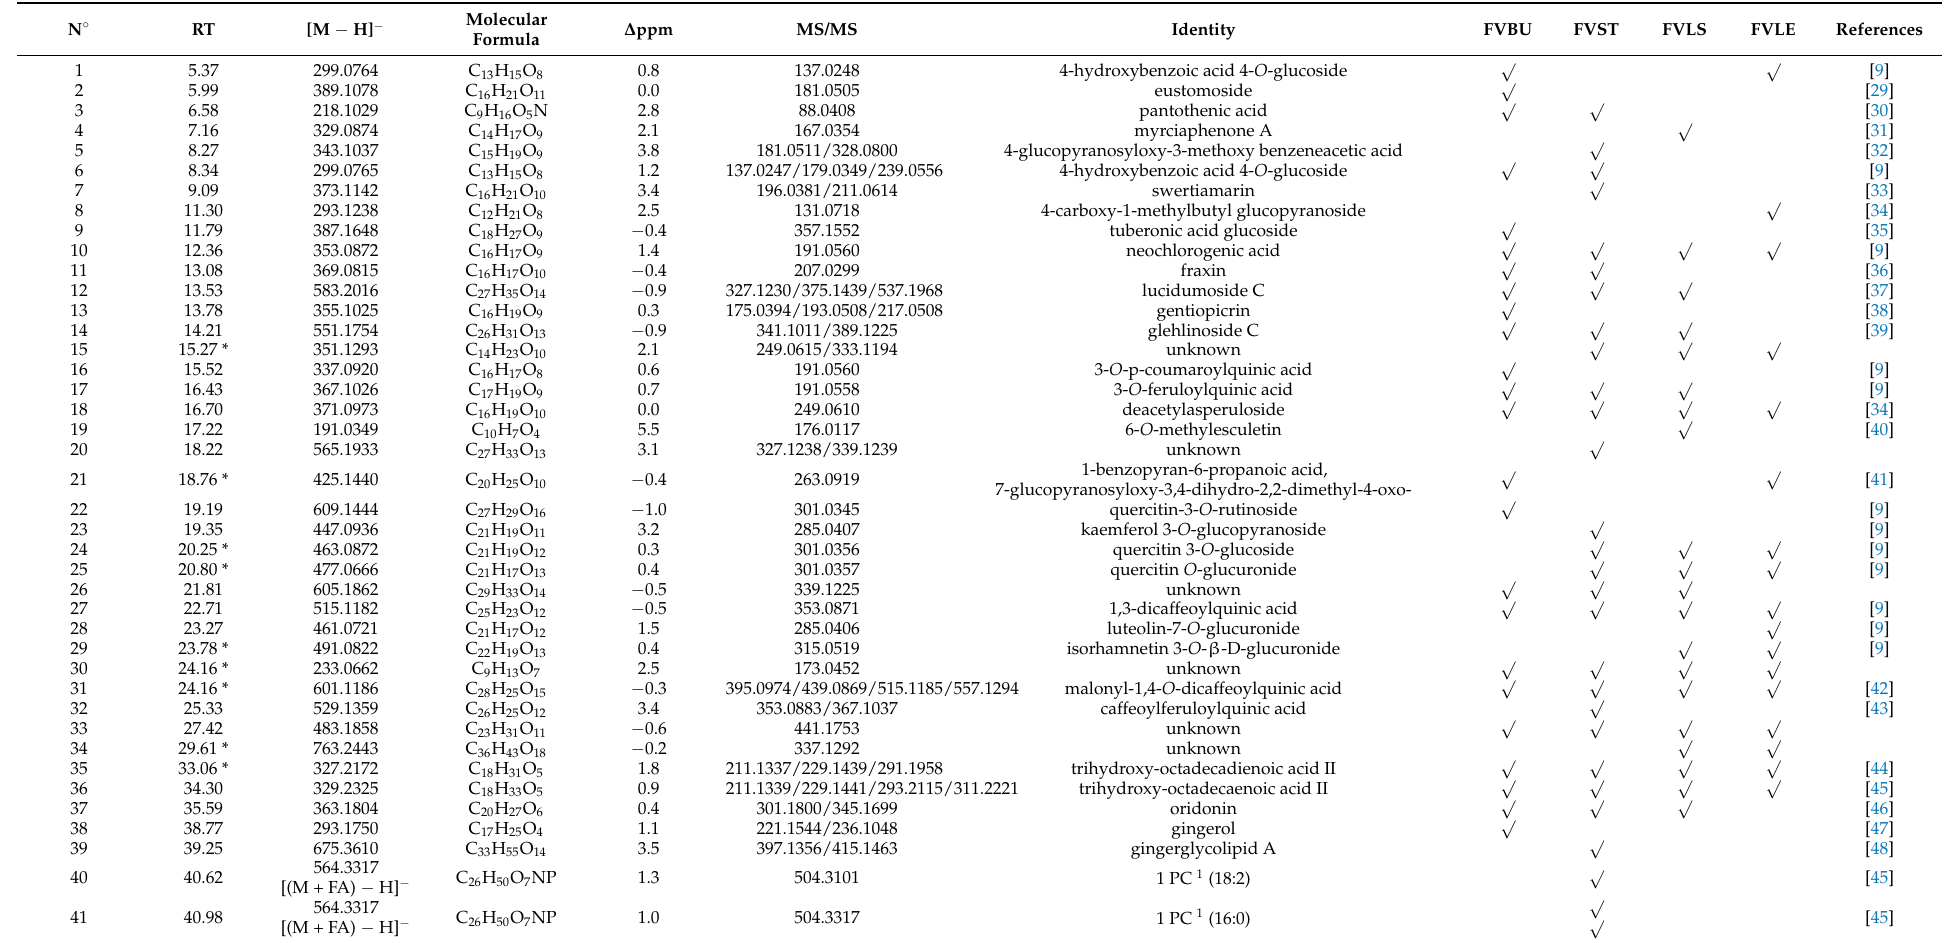
Table 1. Metabolites identified in F. vulgare waste ethanolic extracts by LC-ESI/LTQOrbitrap/MS and LC-ESI/LTQOrbitrap/MS/MS analysis. If the compound is present in several parts of the fennel, the RT is referred to as the profiles of FVBU, except for the compounds with * which are referred to as the profiles of FVLE. N